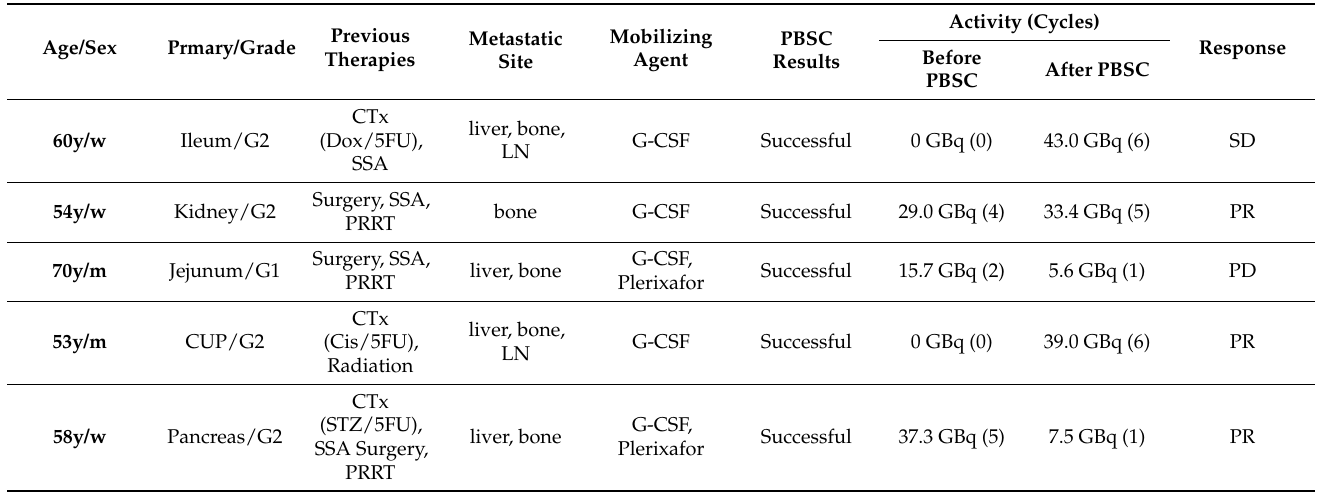
Table 1. Patients’ characteristics and details of